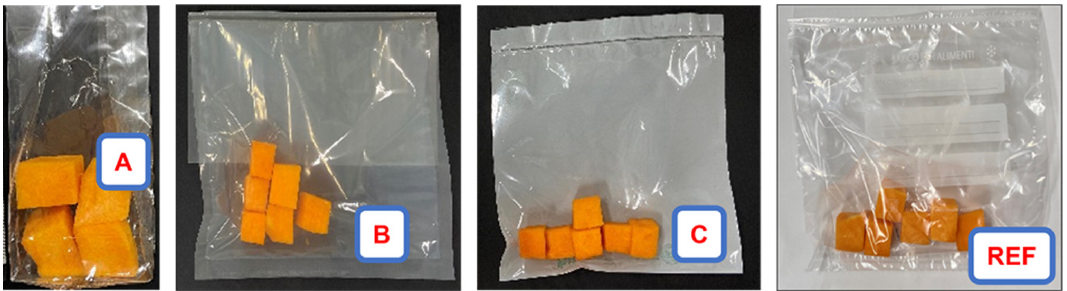
Figure 1. Pumpkin cubes packaged in the commercial biofilms (A, B, C) and polyethylene film (REF).